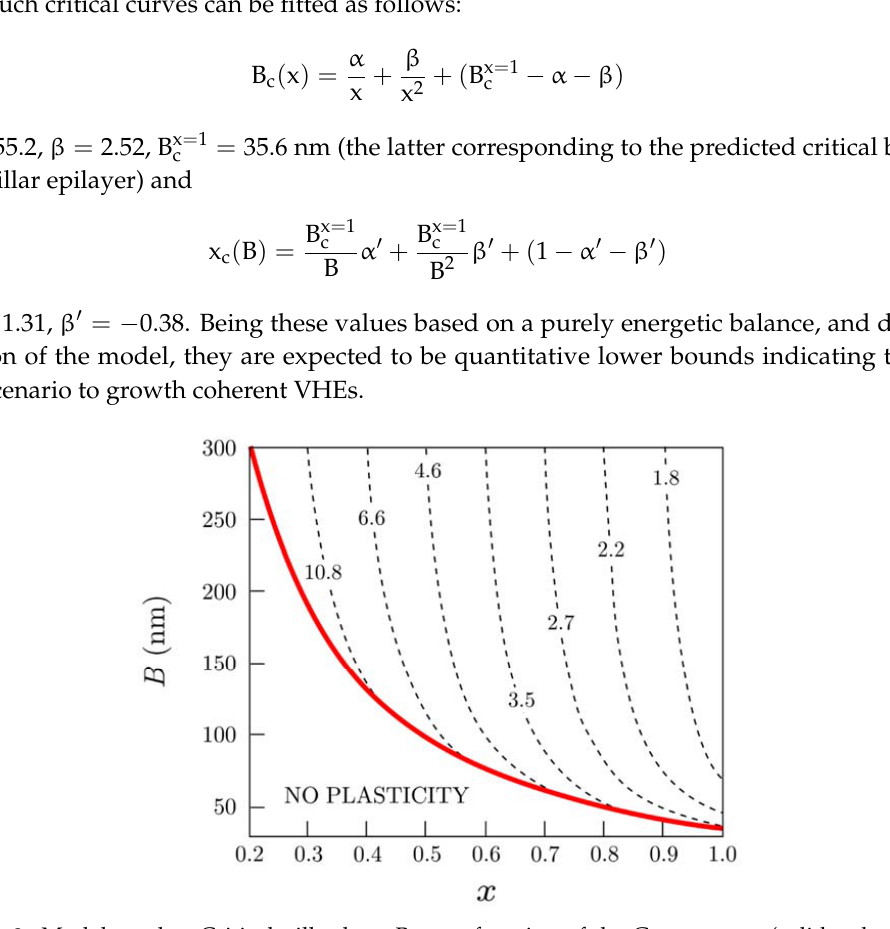
Figure 8. Model results. Critical pillar base B c as a function of the Ge content x (solid red curve) and critical thickness of Si 1 − x Ge x /Si VHEs as function of B and x (dashed black isolines, numbers correspond to h c expressed in nm). Reproduced with permission from [35]. American Institute of Physics.